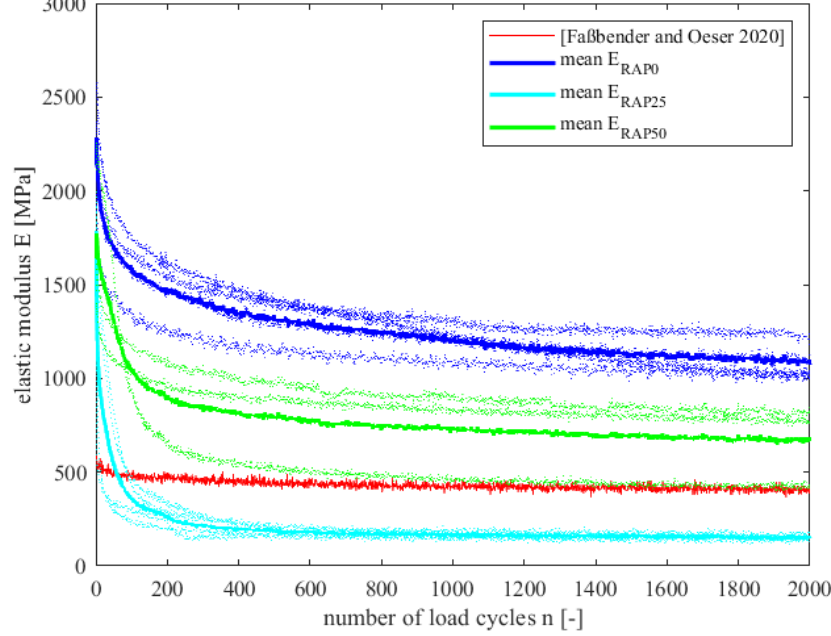
Figure 8. Course of the diminishing e-modulus of variants RAP0, RAP25, RAP50 and